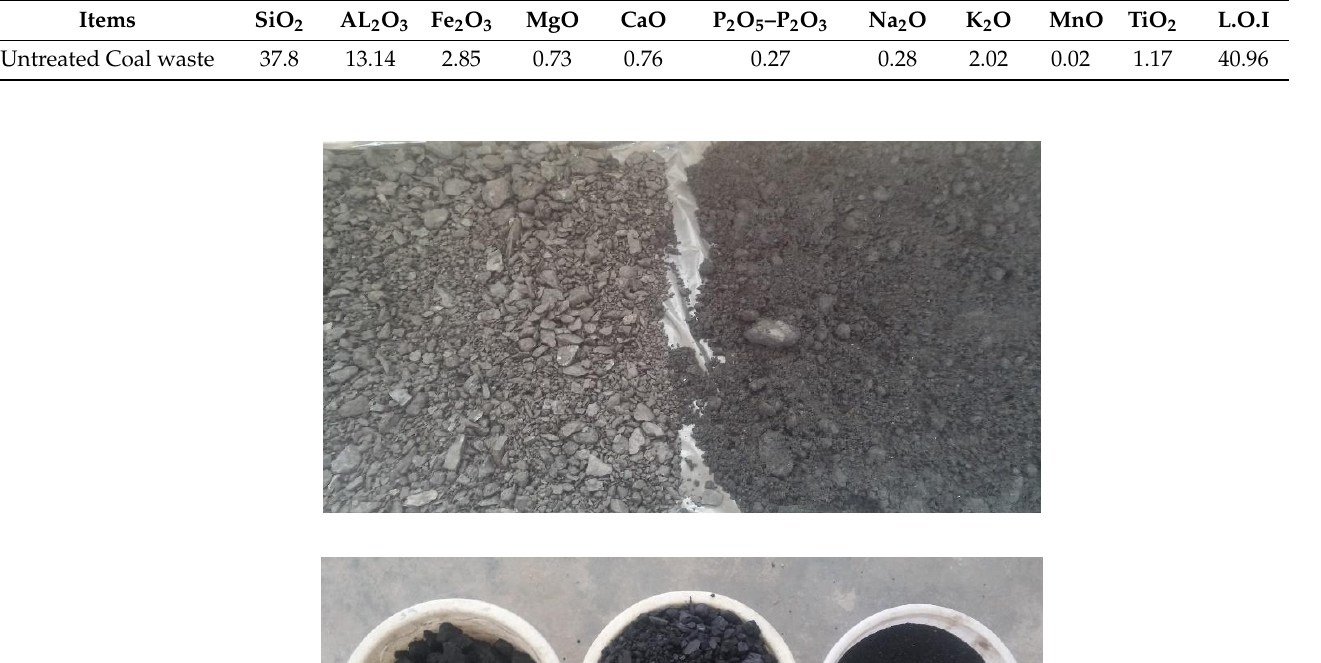
Table 2. Chemical specifications of coal waste.